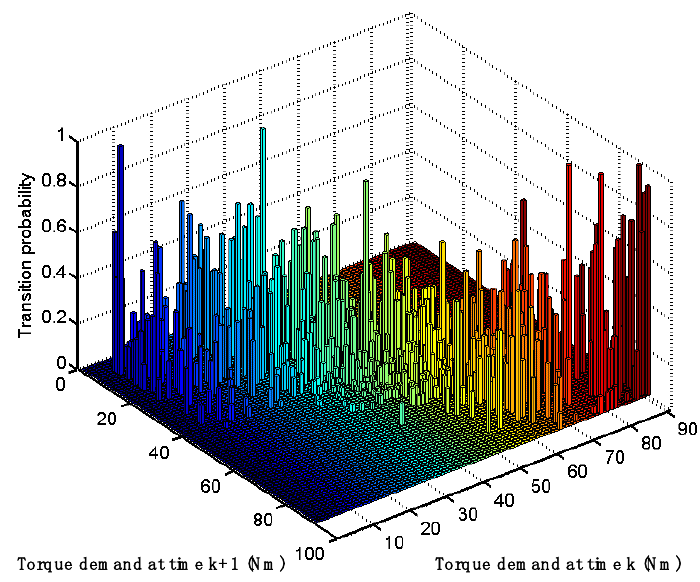
Figure 2. Transition probability of T dem for standard driving cycle UDDS.